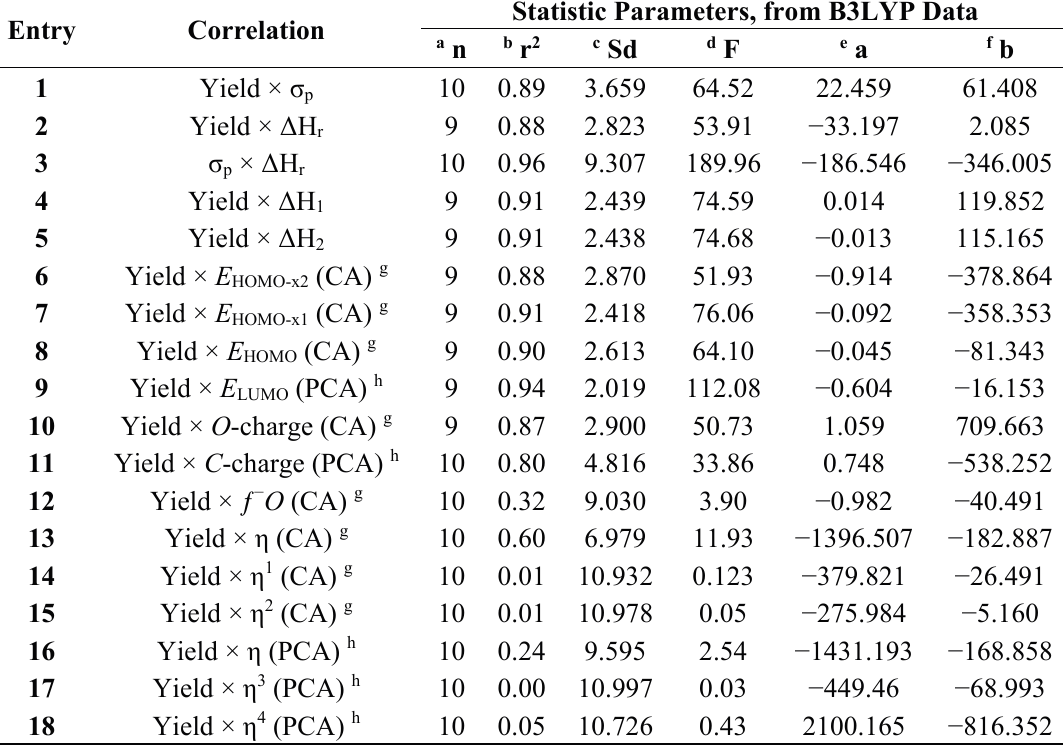
Table 5. Correlations analysis among global properties and enthalpies variations or local properties for the protonated 4- or 3-X-cinnamic acid (PCA) or 4- or 3-X-cinnamic acid (CA), obtained from